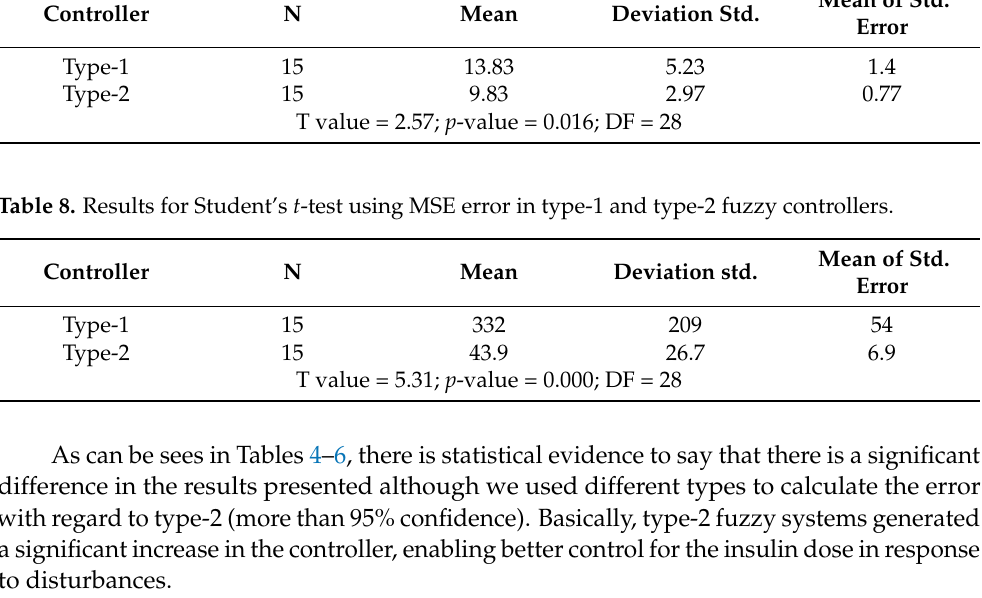
Mean of Std. Error